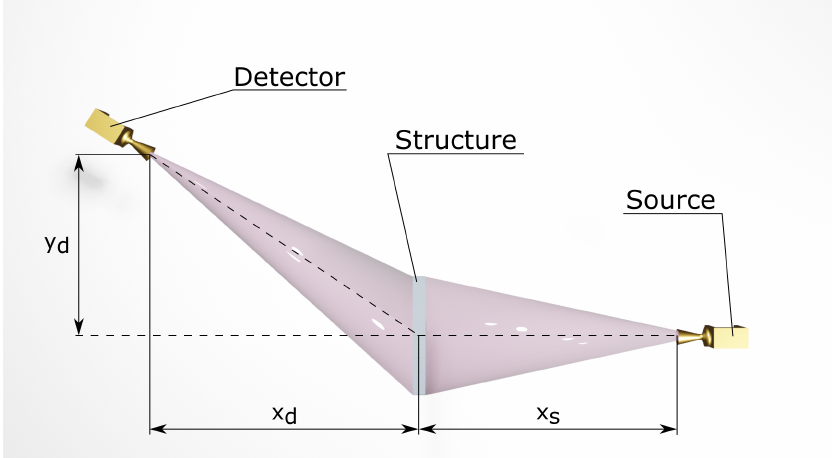
Figure 4. The measurement setup for off-axis diffractive lenses with frequency multipliers with Schottky diodes as a source and a detector of THz radiation. x s = 100 mm is the distance from the source of radiation to the thin structure, x d = 100 mm corresponds to the distance along optical axis from the structure to the image plane and y d = 60 mm reflects the perpendicular shift of the detector (and focal point) from the optical